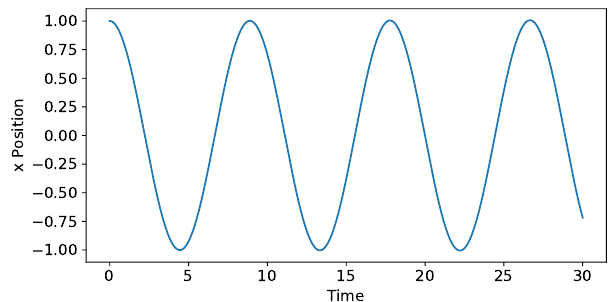
Fig. 103.— Solution of the harmonic oscillator equation with initial position 1.0 and initial speed 0.0